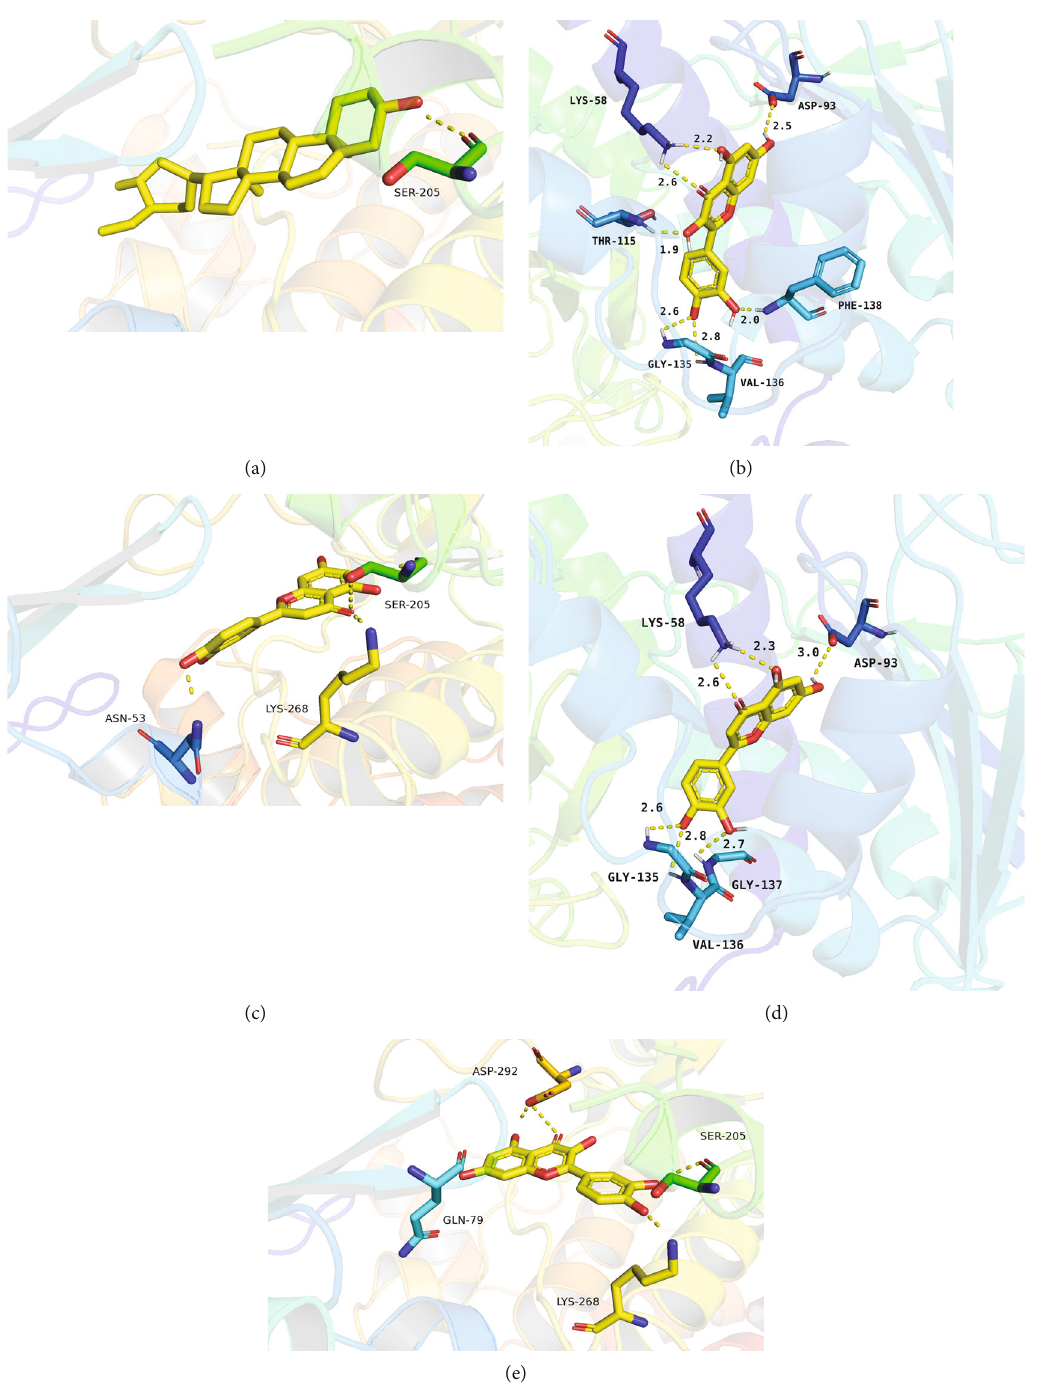
Figure 6: Molecular docking of the receptors and their ligands: (a) β -sitosterol to AKT1; (b) quercetin to HSP90AA1; (c) luteolin to AKT1; (d) luteolin to HSP90AA1; (e) quercetin to